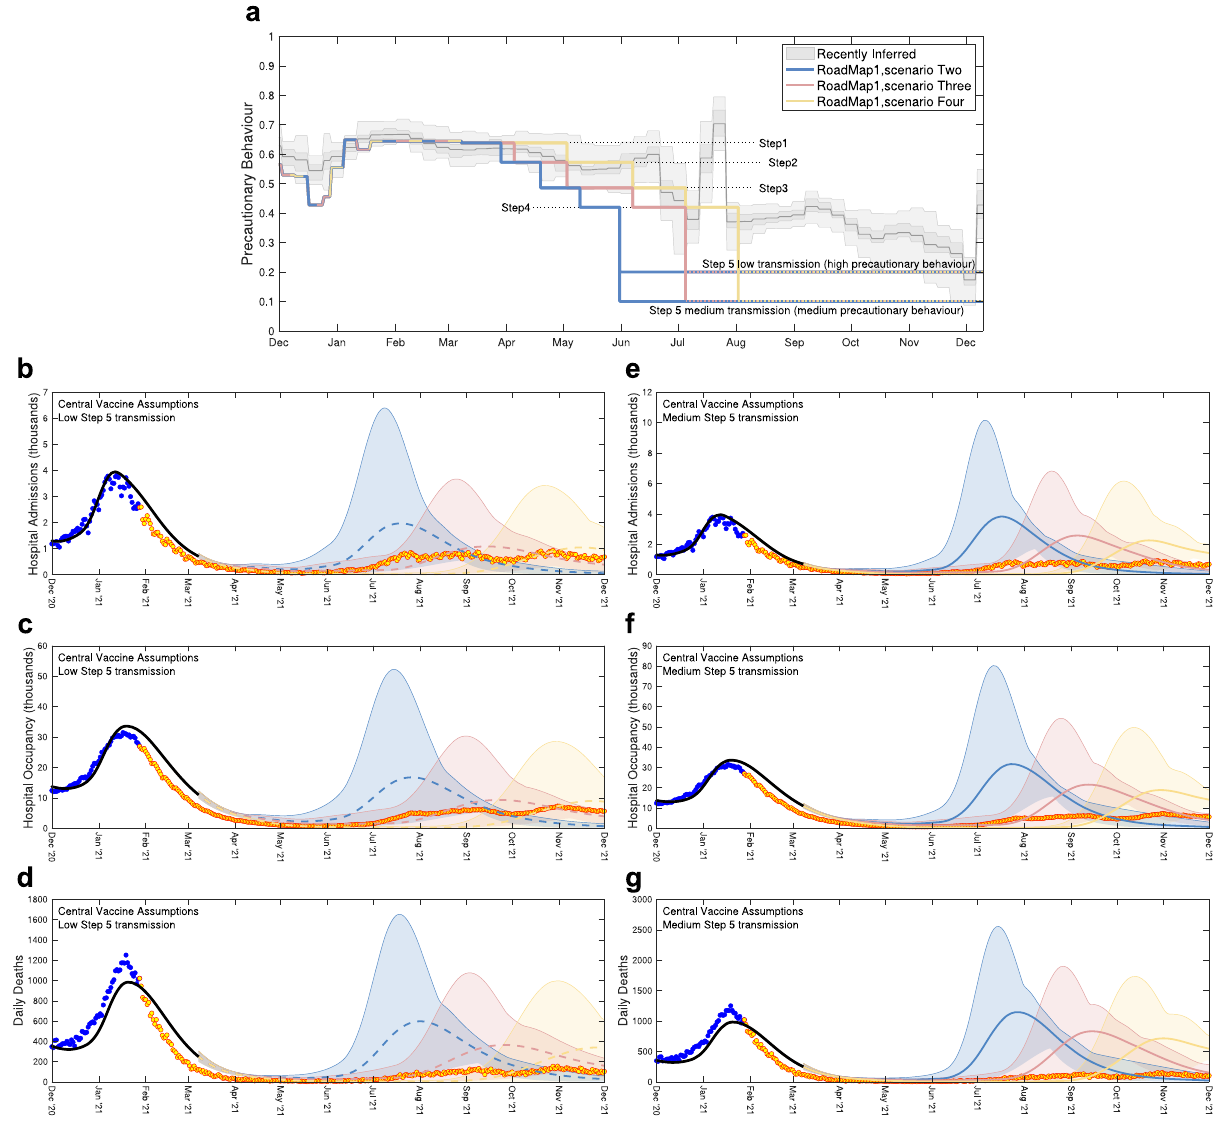
used in parameter inference are in blue, those after the Roadmap are in orange. Linesarethemedianvalues,whileshadedregionscorrespondtothe95%prediction interval; blue for Scenario Two, orange for Scenario Three and yellow for Scenario